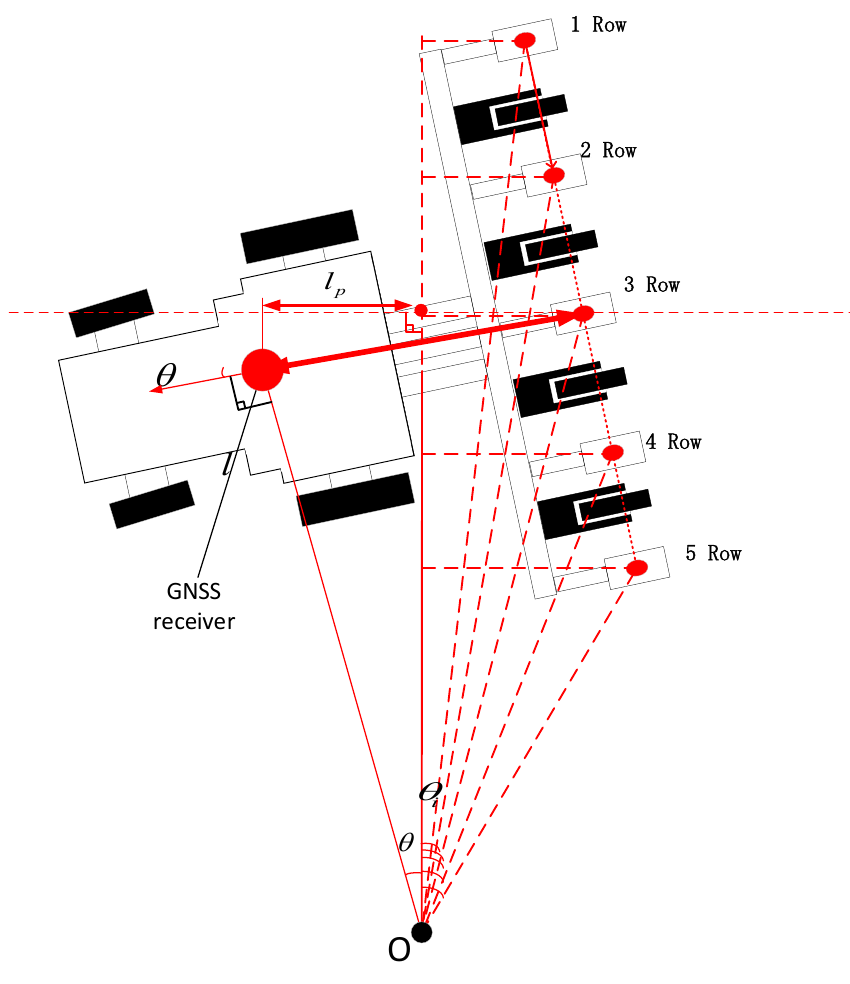
Figure 4. Calculation of Turning Radius.